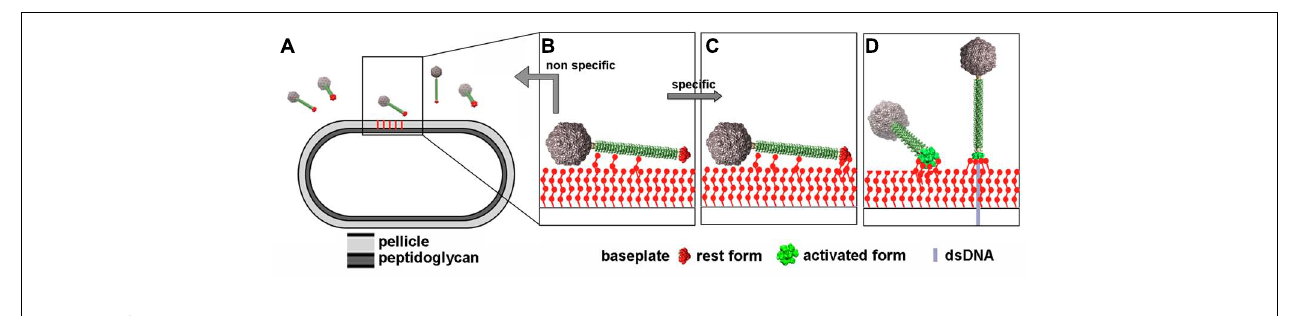
FIGURE 11 | Putative infection mechanism of L. lactis MG1363 by phage p2. (A) The phages in the vicinity of the host. (B) Weak interactions are established between the tail adhesins and putatively the pellicle. (C) Strain- specific lateral interactions may occur between the phage RBPs of the resting